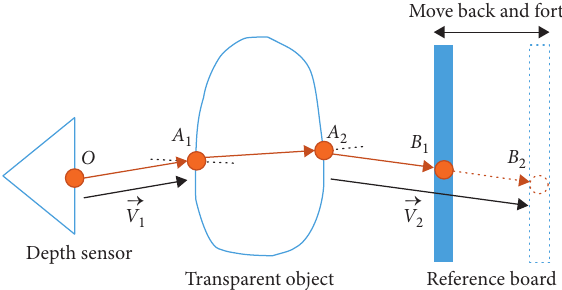
Figure 2: Detecting distance principle between surfaces of the transparent